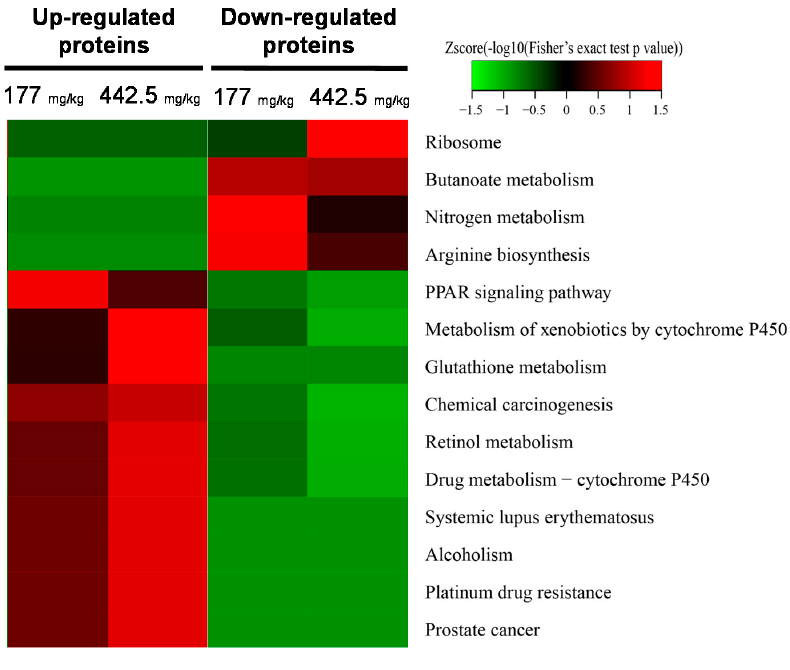
Figure 4. KEGG pathway enrichment-based clustering analysis of quantified proteins. The KEGG database was used to identify enriched pathways by a two-tailed Fisher’s exact test to determine the enrichment of each differentially expressed protein against all identified proteins. p -value < 0.05.